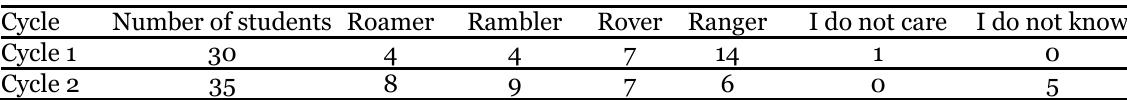
Student Response to the Use of the Playful Approach Choice Cycle Strongly I actively participated in the journey The journey helped maintain motivation The journey led to a positive behaviour change